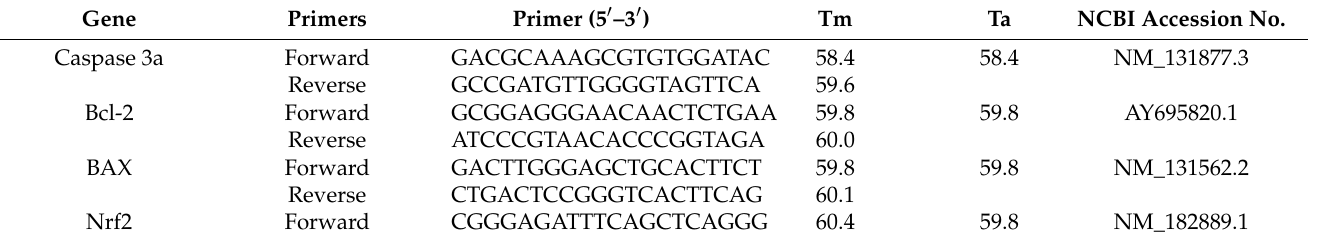
Table 1. Gene-specific primers for the studied target and housekeeping genes from D. rerio .